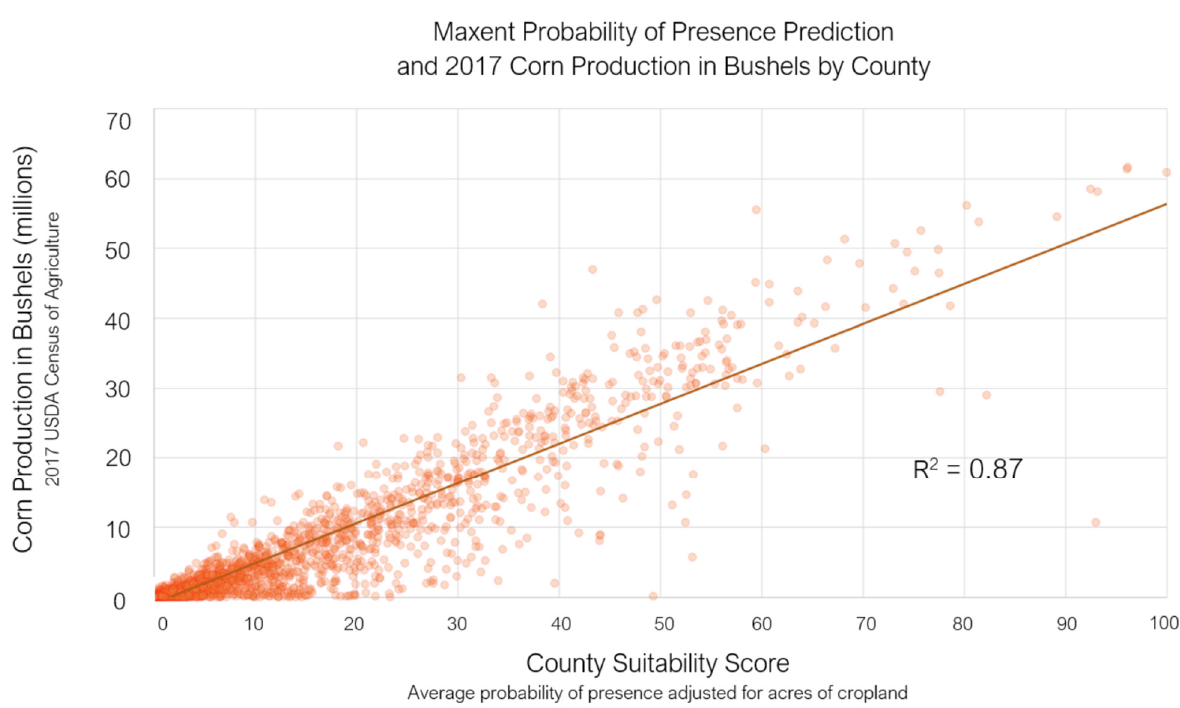
Figure 8. Correlation between cropland suitability score and observed corn production in bushels. Cropland suitability score is probability of presence, aggregated by county, and normalized by cropland area per county in order to adjust for counties with high suitability but little cropland.